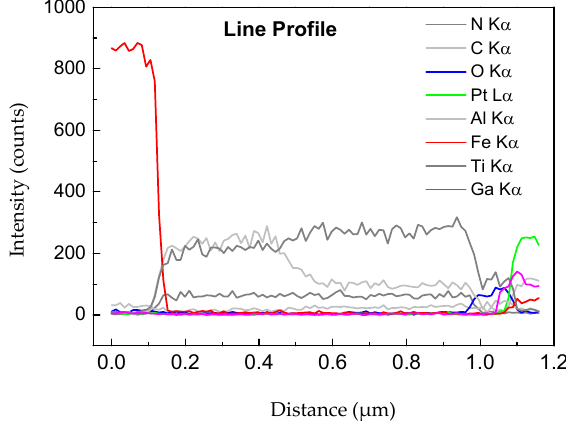
Figure 7. EDS linear profile of all detected elements.